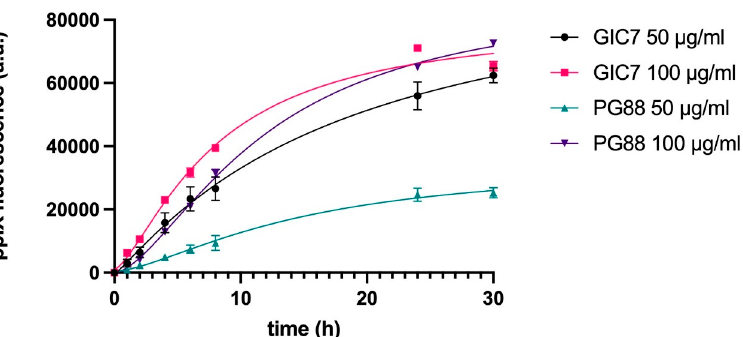
Figure 5. Kinetic study of PpIX emission of GICs. Both GIC7 and PG88 tumorspheres were treated at 50 and 100 µg/mL of 5-ALA and PpIX fluorescence was analyzed. Results show the mean ± SE of three independent experiments ( n = 3) performed in triplicate and measured periodically until 30 h after 5-ALA administration.